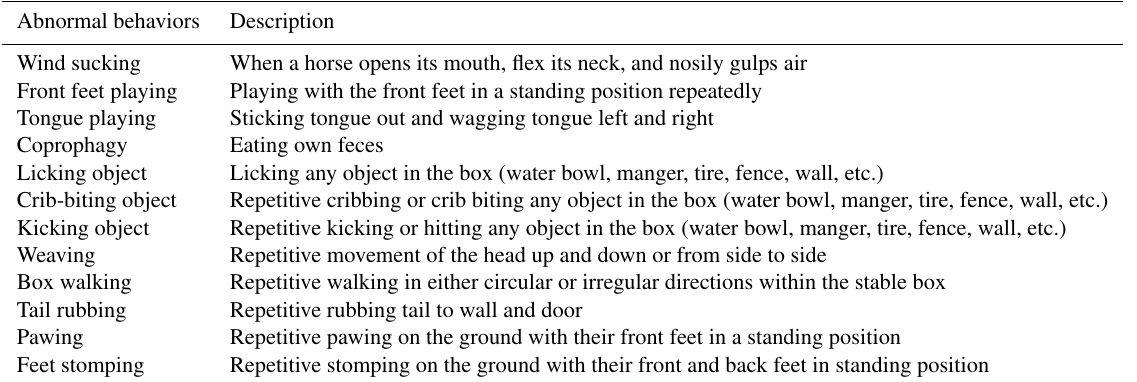
Table 3. Description of abnormal horse behaviors observed. Abnormal behaviors